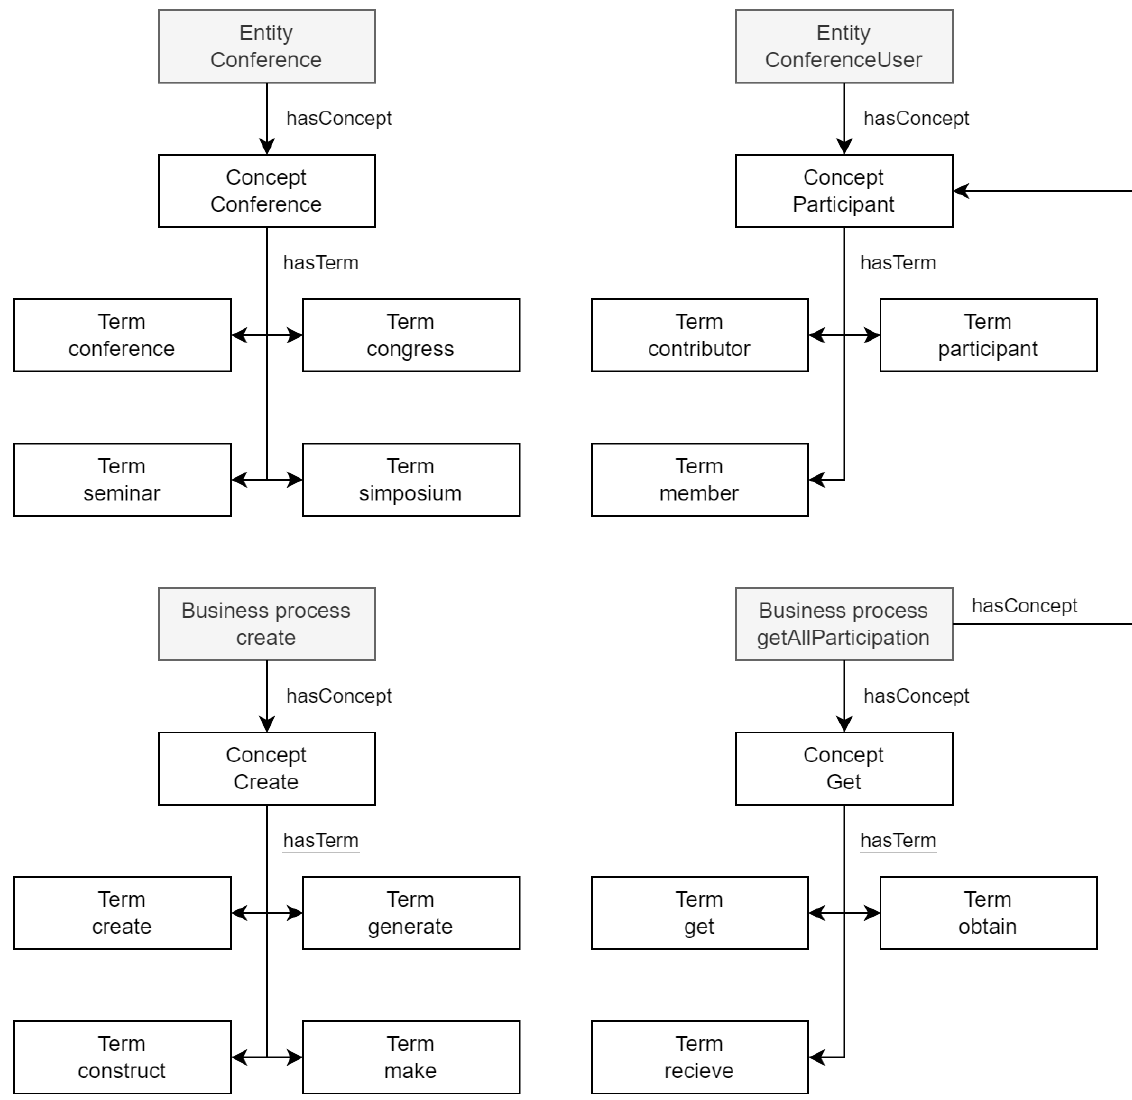
Figure 7. Example of the fragment of the W B representation of the linguistic